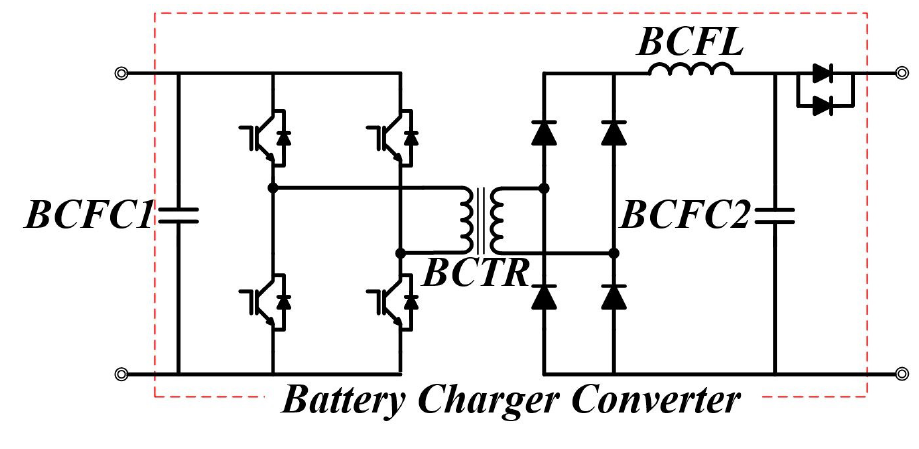
Figure 12. Part of the battery charger converter.